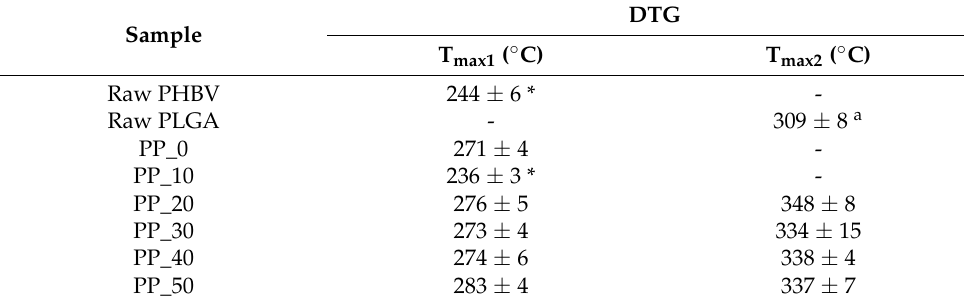
Table 3. Data relevant to TGA